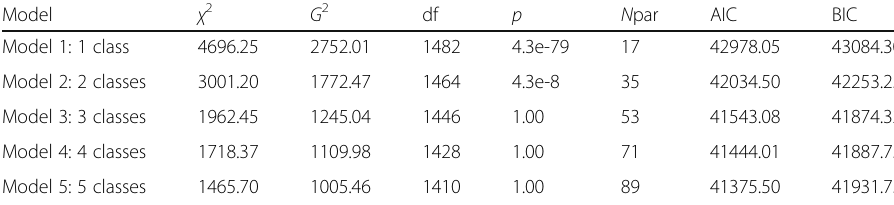
Table 3 Explorative fitting of latent class analysis models, N = 3827